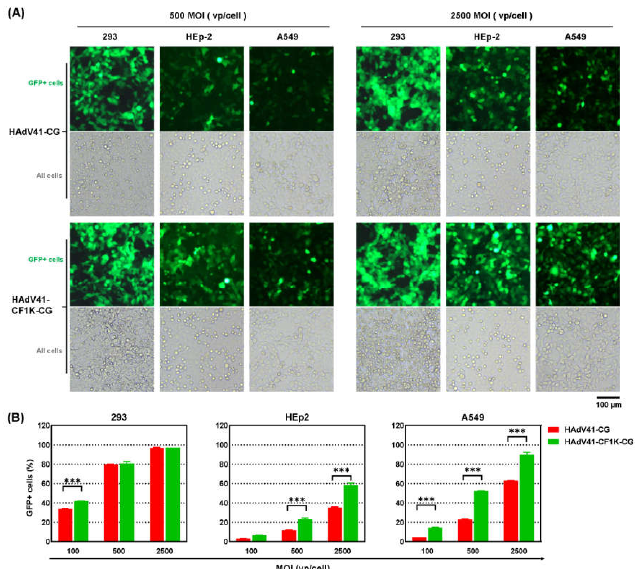
Figure 7. Transduction of human adherent cell lines with fiber-modified HAdV-41 vector carrying GFP reporter gene. ( A ) Human 293, HEp-2 and A549 cells were infected with HAdV41-CF1K-CG at an MOI of 100, 500 or 2500 vp/cell for 4 h, and the expression of GFP was observed under a